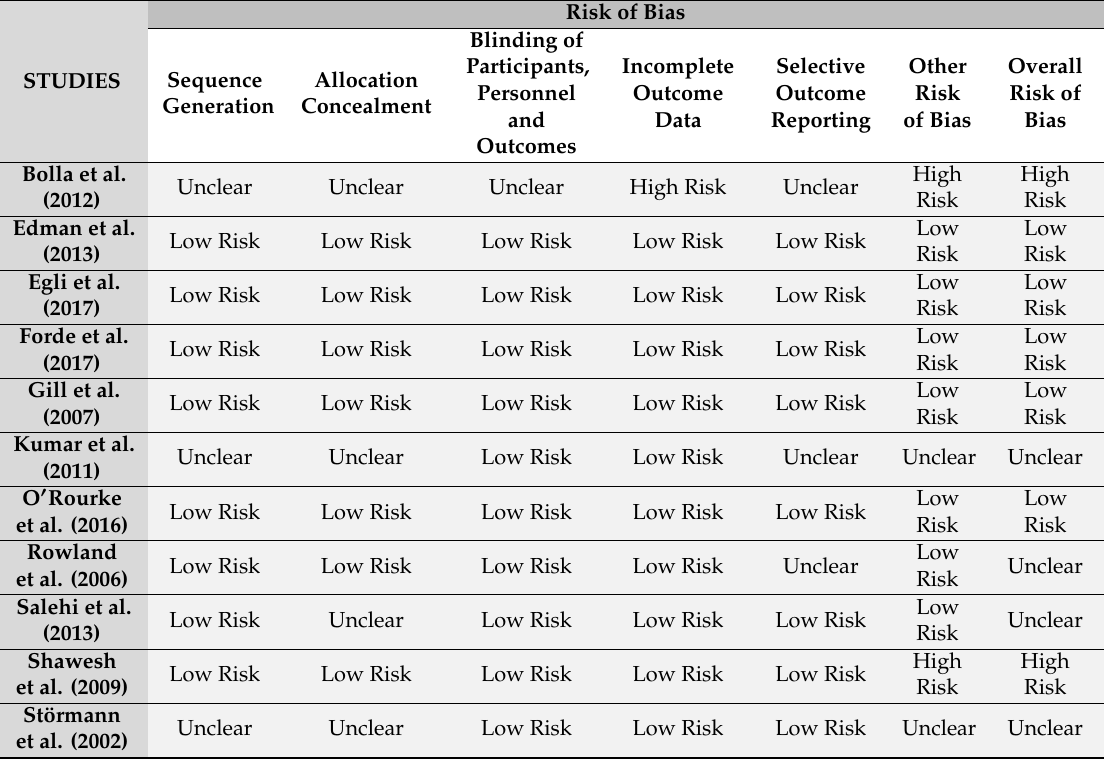
Table 3. Risk of bias